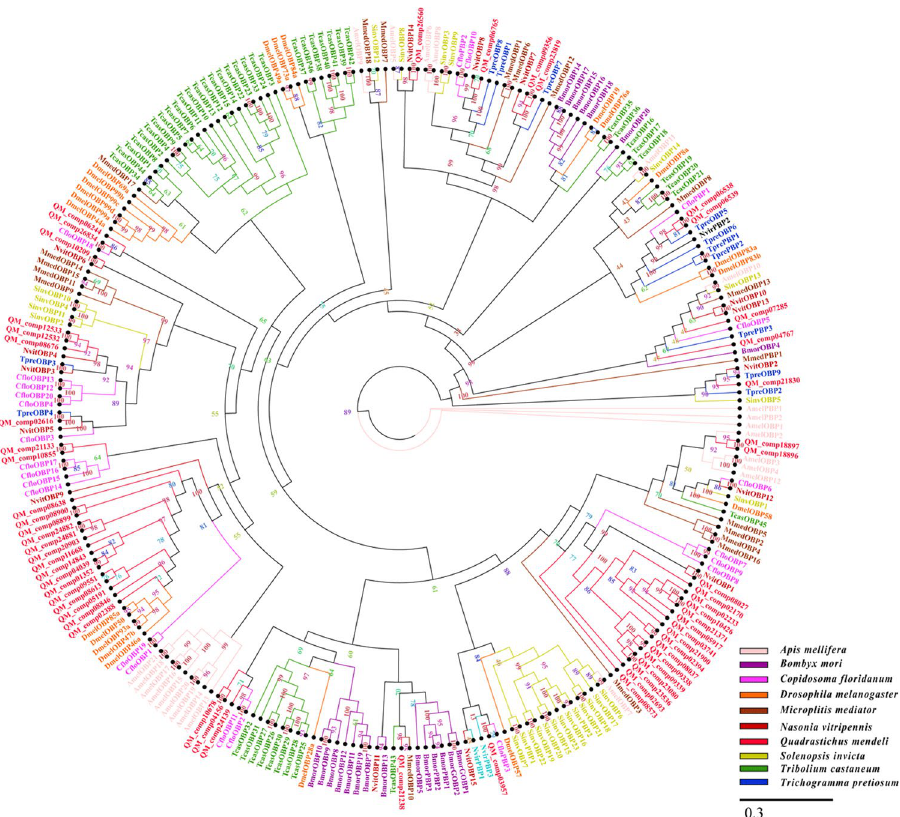
Figure 5. Phylogenetic tree of odorant binding proteins (OBPs) from Quadrastichus mendeli and other insects based on the maximum likelihood method. Included are OBPs from Apis mellifera (Amel), Bombyx mori (Bmor), Copidosoma floridanum (Cflo), Drosophila melanogaster (Dmel), Microplitis mediator (Mmed), Nasonia vitripennis (Nvit), Quadrastichus mendeli (Qmen), Tribolium castaneum (Tcas), and Trichogramma pretiosum (Tpre). The specific clades are marked. Node support was assessed with 1000 bootstrap